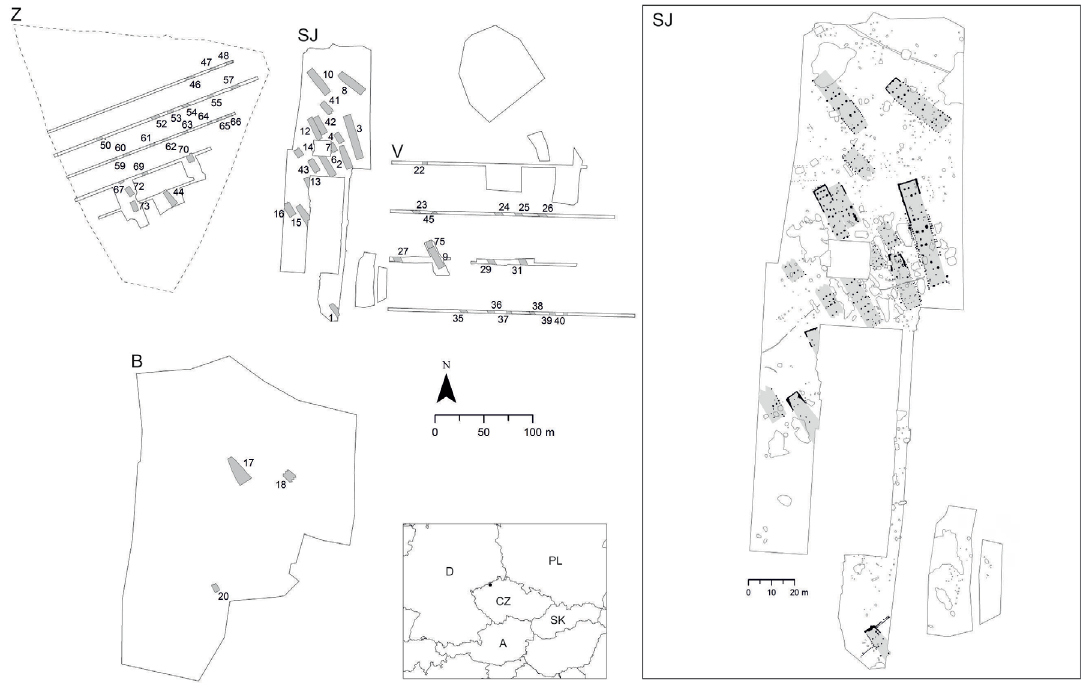
Figure 1. Plan of Hrdlovka settlement with marked overburden areas and numbers of longhouse ground plans. Detail of SJ area on the